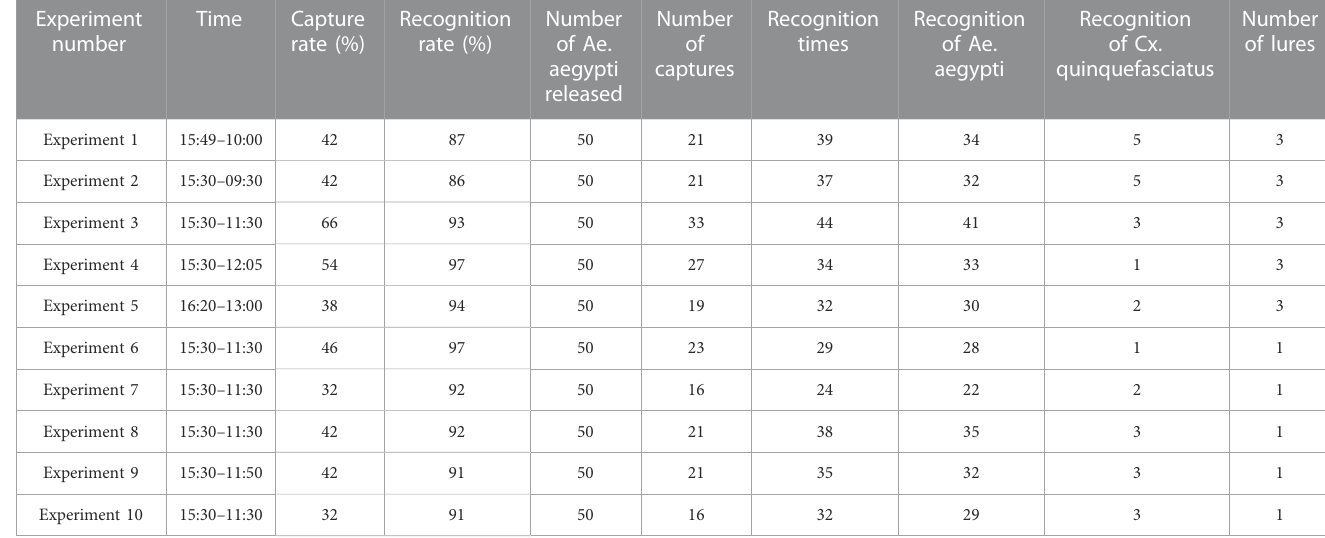
TABLE3Performancetestresultsofthecoredeviceofthemosquitotrapintheinsectcage.ThetestsetupisshowninFigure5.Fifty Ae.aegypti mosquitoeswereplaced intotheinsectcage.Themosquitoeswereallowedto fl yfreelyinthelimitedspaceandwerecapturedandidenti fi edbythemosquitotrap.Thesizeofthetestedinsect cage was 60 cm × 60 cm × 120 cm, and the test environment temperature was maintained at 27 ° C ± 1 ° C by an air conditioning system. Each test was performed independently and repeated 10